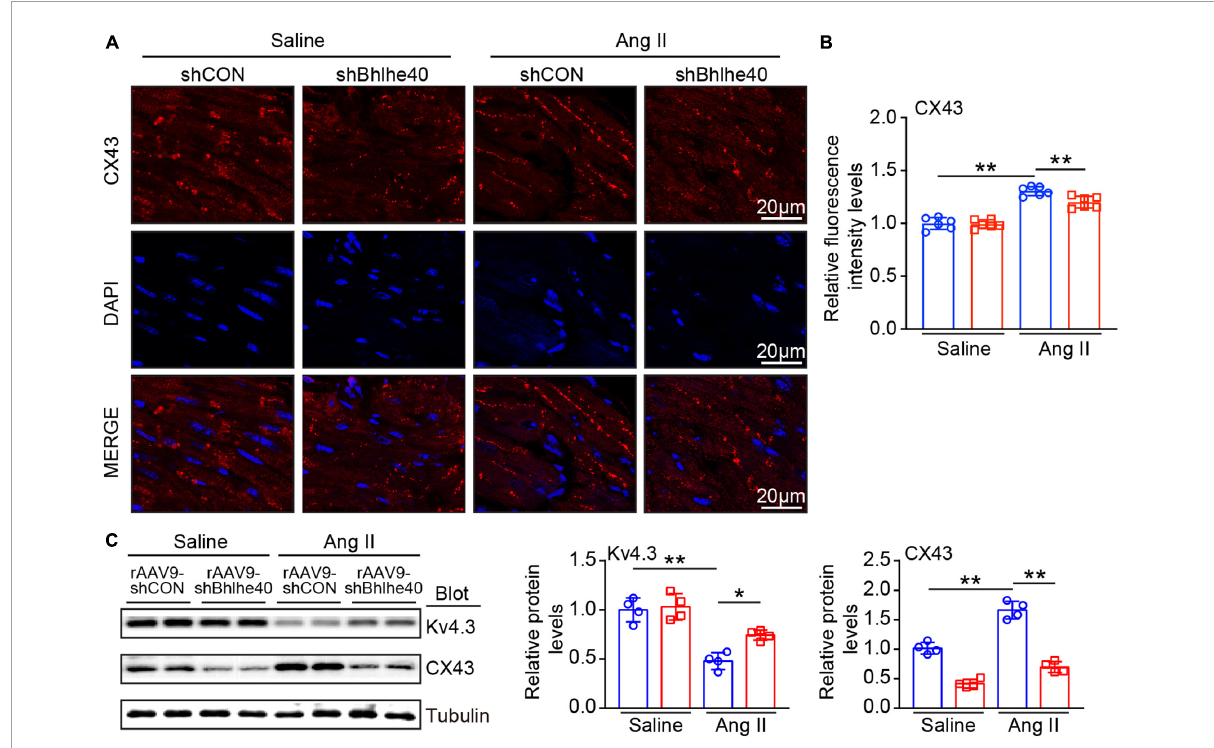
FIGURE5 Knockdown of Bhlhe40 by rAAV9-shBhlhe40 injection reduces Ang II-induced atrial electrical remodeling. (A) Representative immunofluorescence for Cx43 (red) in atrial tissues from Ang II-infused or saline-infused mice. (B) Quantification of the intensity of CX43 expression in atrial tissues. (C) Immunoblotting analyses (left) and quantification of ion channel subunits and connexin (Kv4.3and CX43) in atrial tissues ( n = 4). Tubulin was used as an internal control. n represents the number of animals ( n = 4). * P < 0.05, ** P <